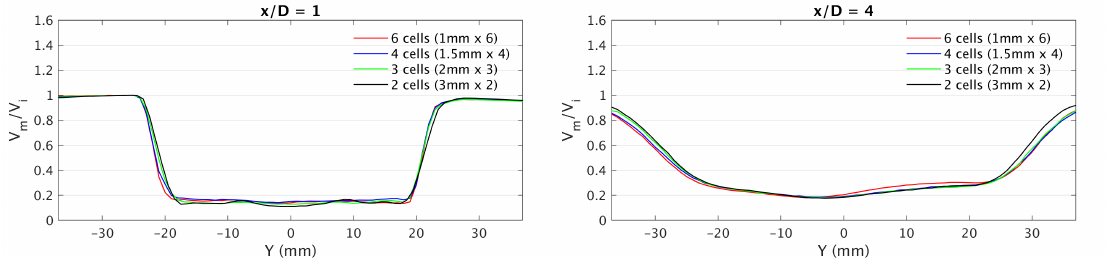
Figure 19. Velocity profiles for cylinders